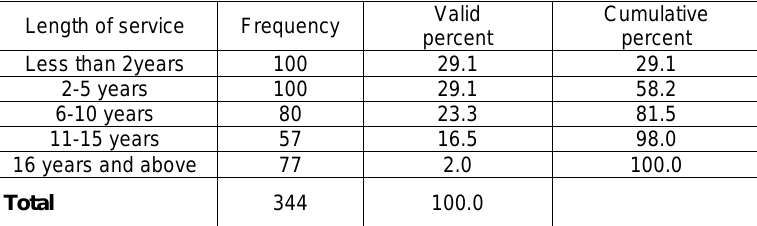
Table 6: Analysis of users of hospital buildings by length of service